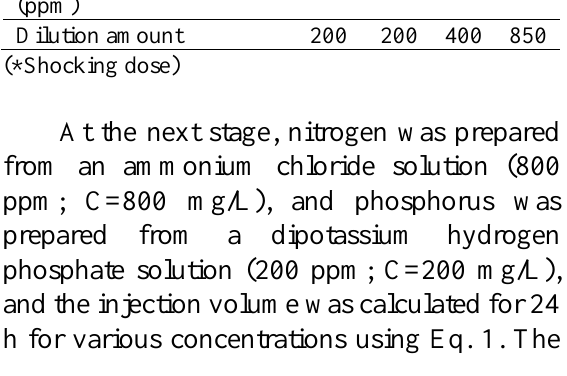
Table 2. Dilution amount of each folic acid concentration with demineralization water Folic acid